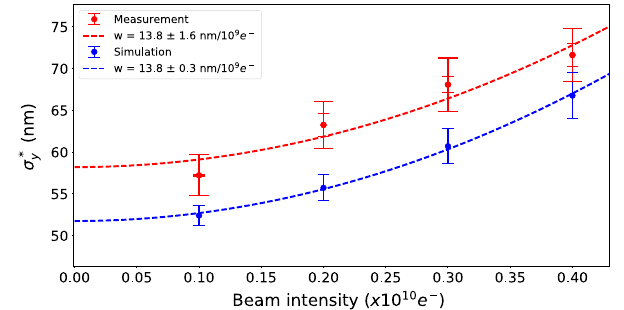
FIG. 10. Comparison between measurements and simulations of the average IP vertical beam size ( σ (cid:1) y ) vs the beam intensity. For each experimental data point the longer error bar shows the quadratic sum of the statistical and the systematic errors and the shorter error bar shows the systematic error. The lines show fits of Eq. (1).